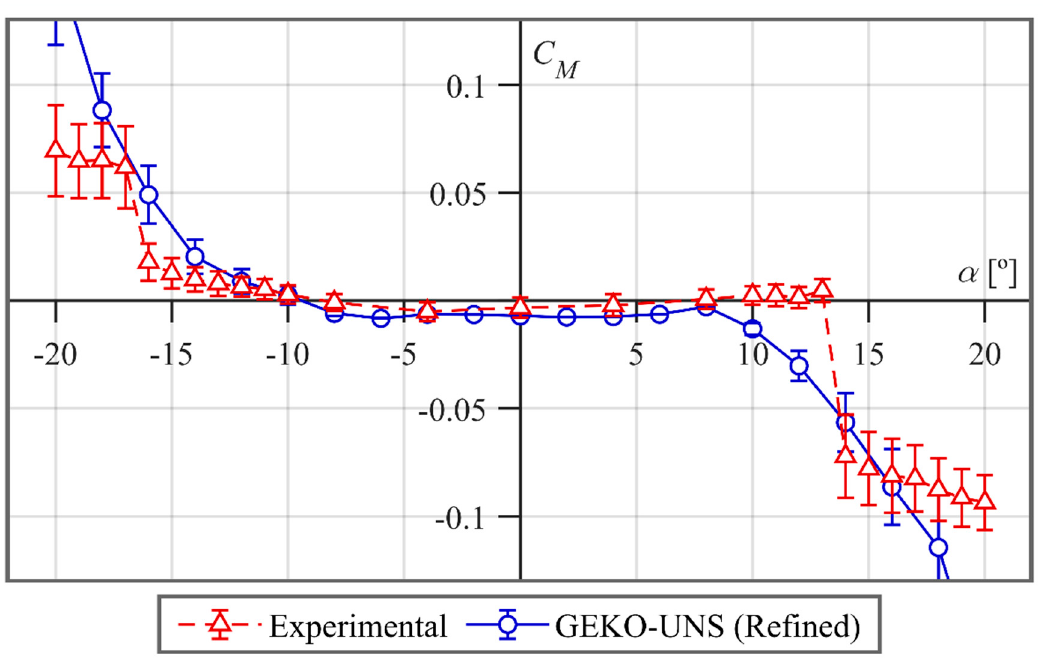
Figure 8. Experimental moment coefficient and fluctuating moment coefficient from airfoil DU06- W-200 compared with results from the best unsteady CFD